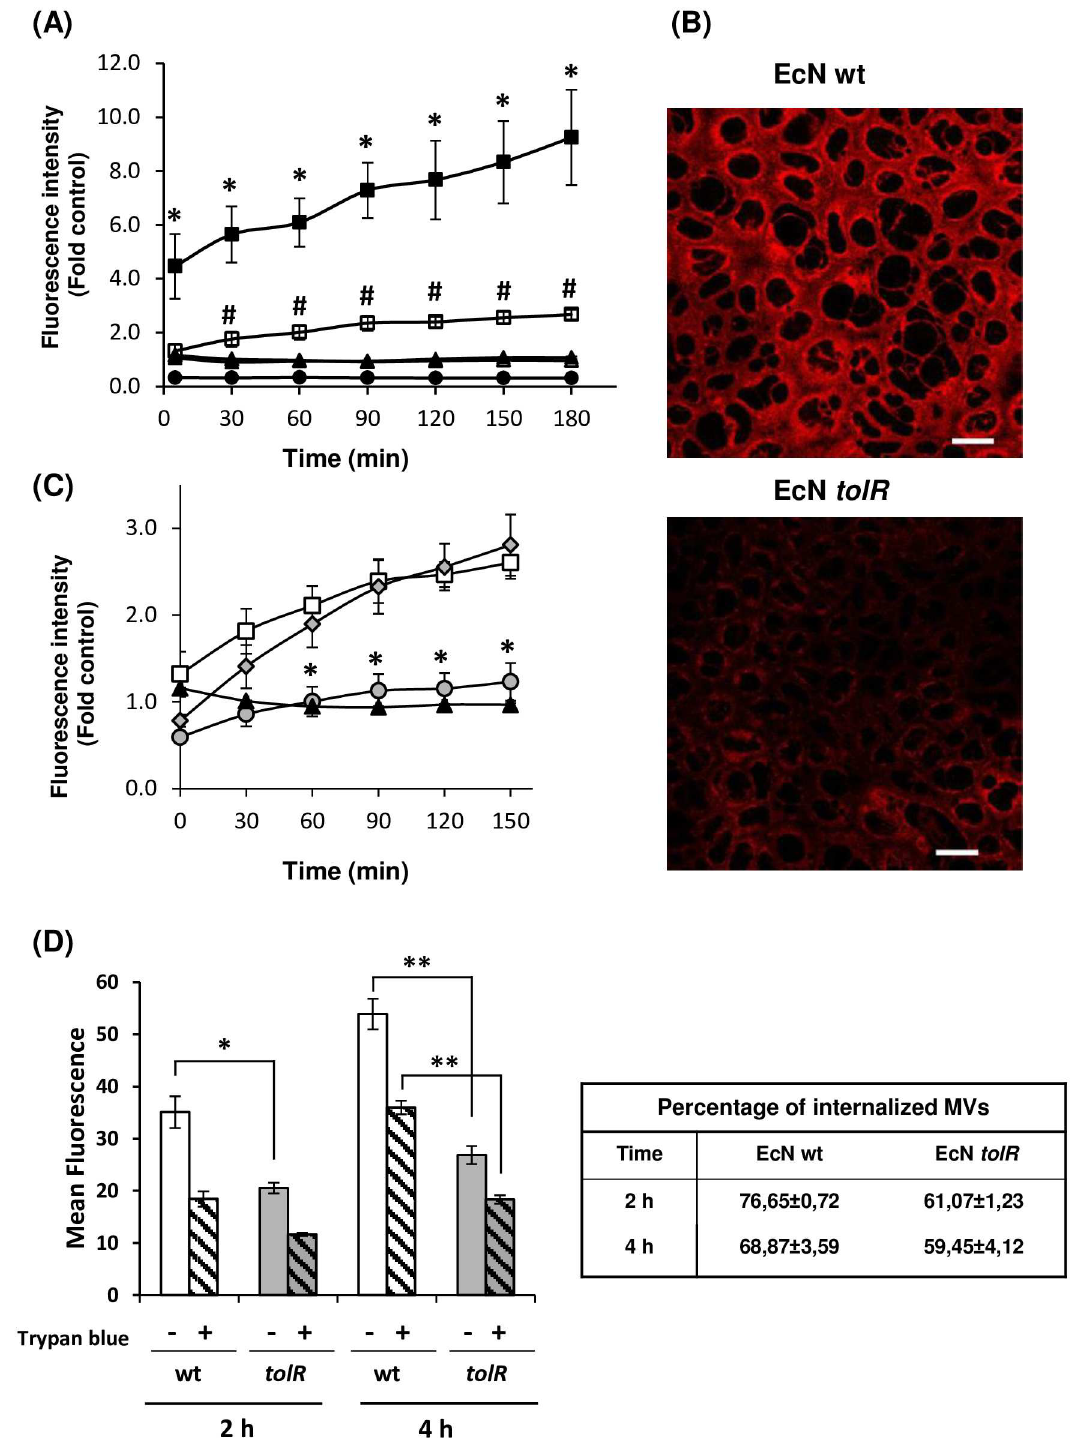
Fig 5. MV uptake by Caco-2 cells. (A) RhodamineB-R18-labeled MVs (1 μ g protein) from EcN (closedsquares) or EcN tolR (open squares)were appliedto polarizedCaco-2 cells and fluorescence was measuredover time. Caco-2 cells (circles) and MVs (triangles)alone were used as controls of background fluorescence. Values are means ± standard error from three independentexperiments. Statistical differenceswere assessedusing one-wayANOVA followedby Tukey’s test. * P < 0.02,cells incubatedwith labeledMVs versus the background fluorescence emitted by MVs alone; # P <